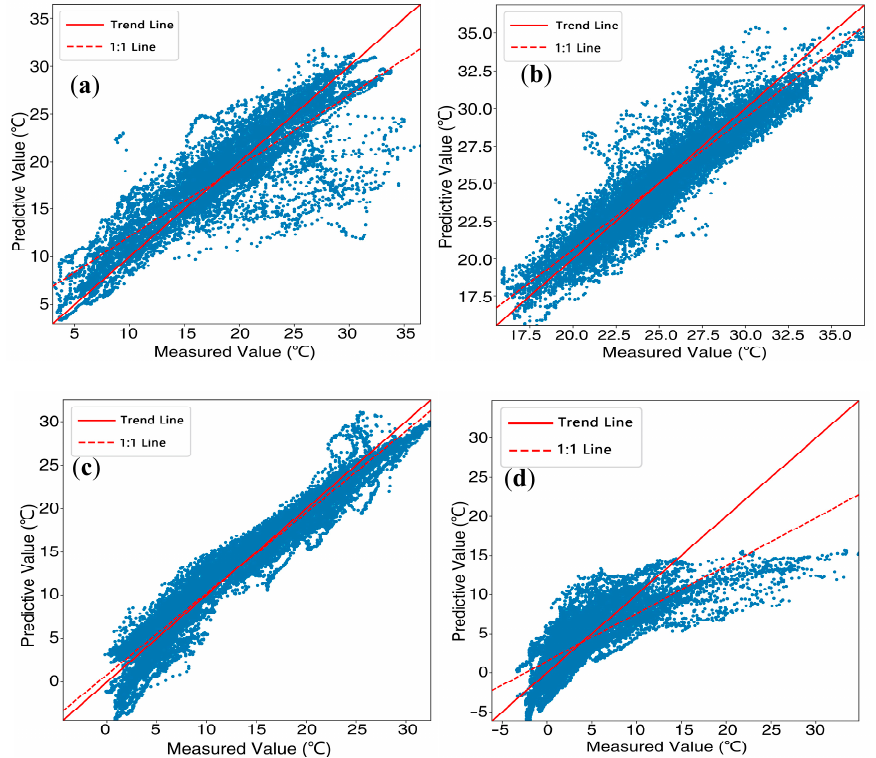
Figure 3. Prediction model of temperature based on stepwise regression. ( a ) Spring. ( b ) Summer. ( c ) Autumn. ( d ) Winter.